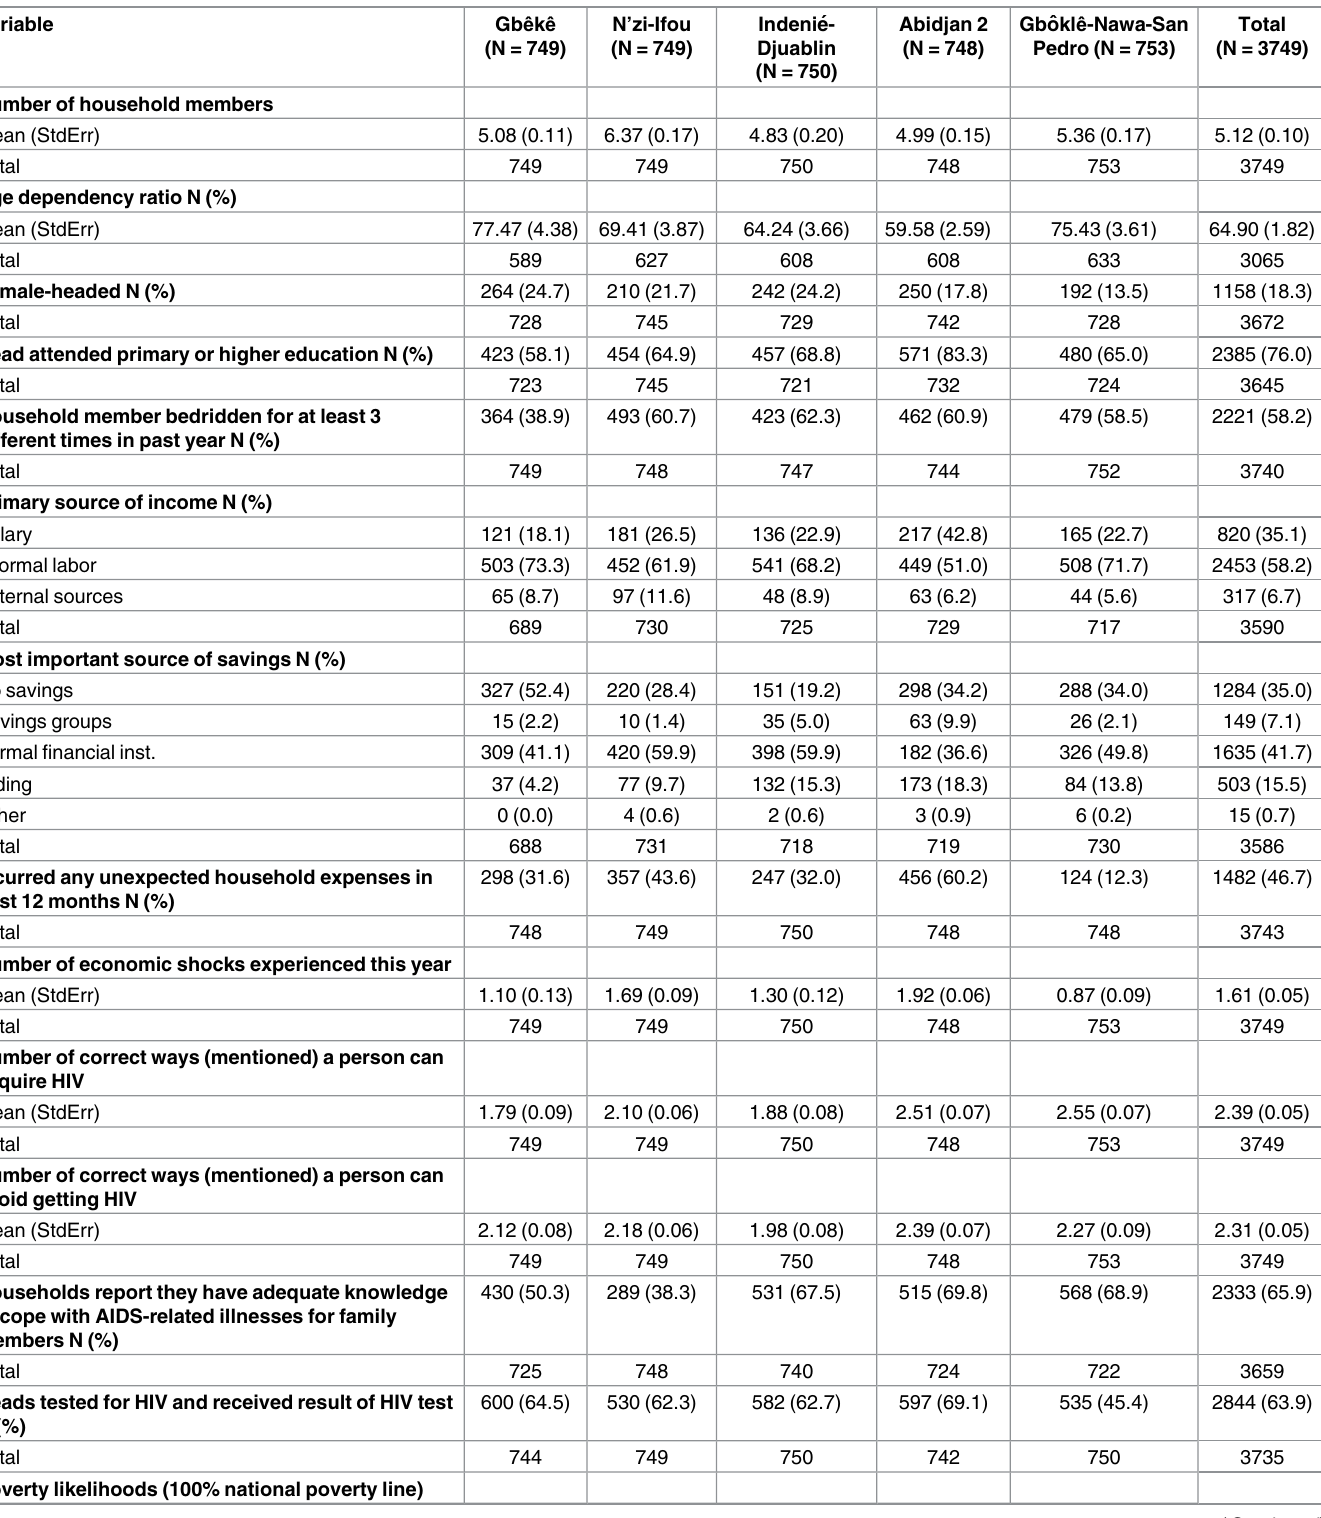
Table 1. Select characteristics of households by region. 1,